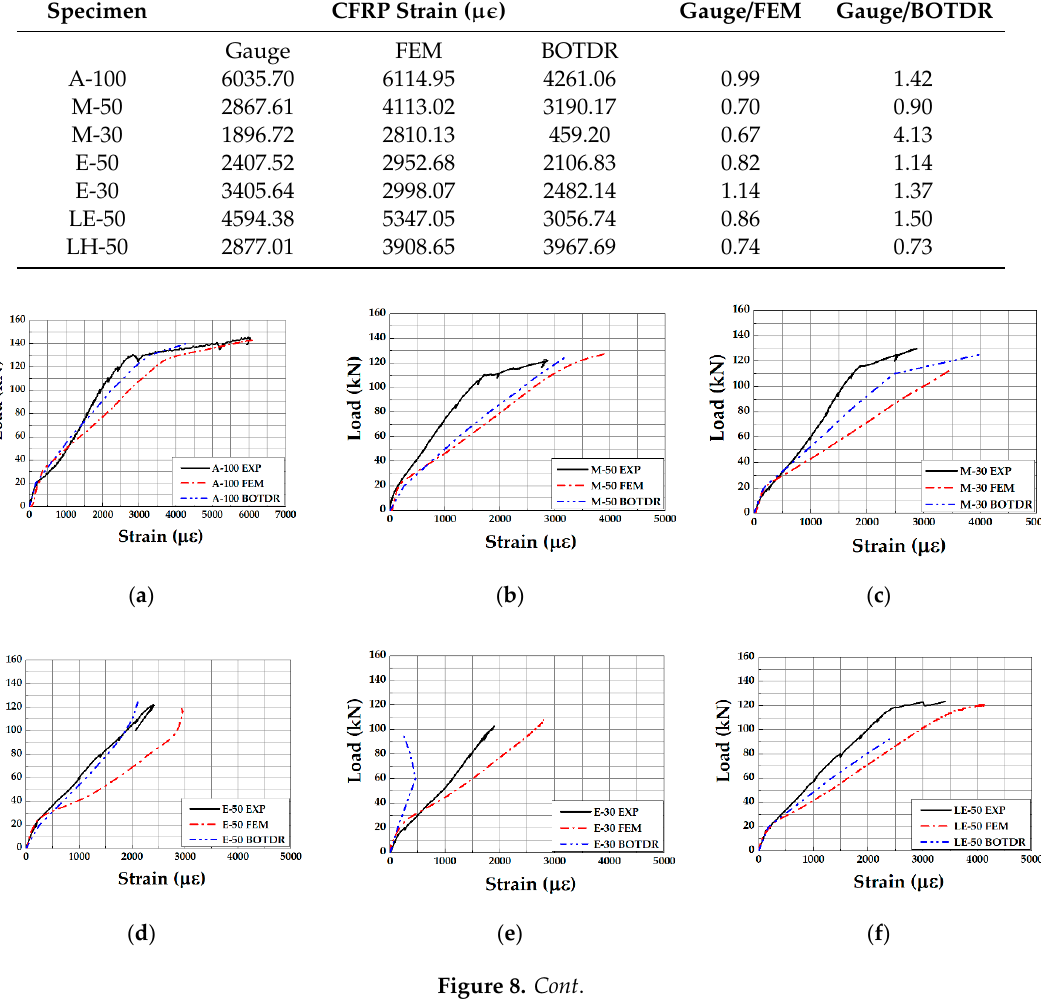
Table 4. Comparison of the strains in the carbon-fiber-reinforced polymer (CFRP) sheet. Specimen